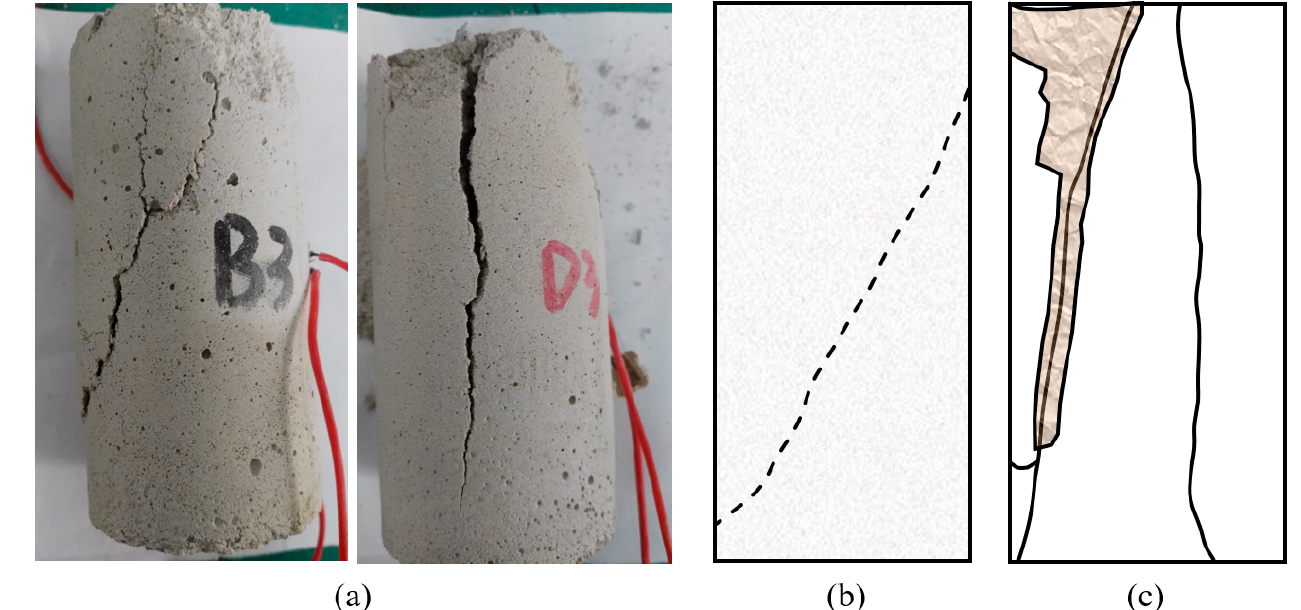
Figure 6. Final failure modes: ( a ) cement mortar, ( b ) sandstone-1 ( c ) sandstone-2. Table 1. Mechanical parameters of cement mortar.